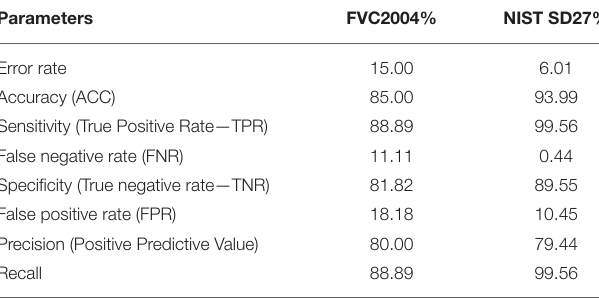
fingerprint datasets with two different classes are formed.